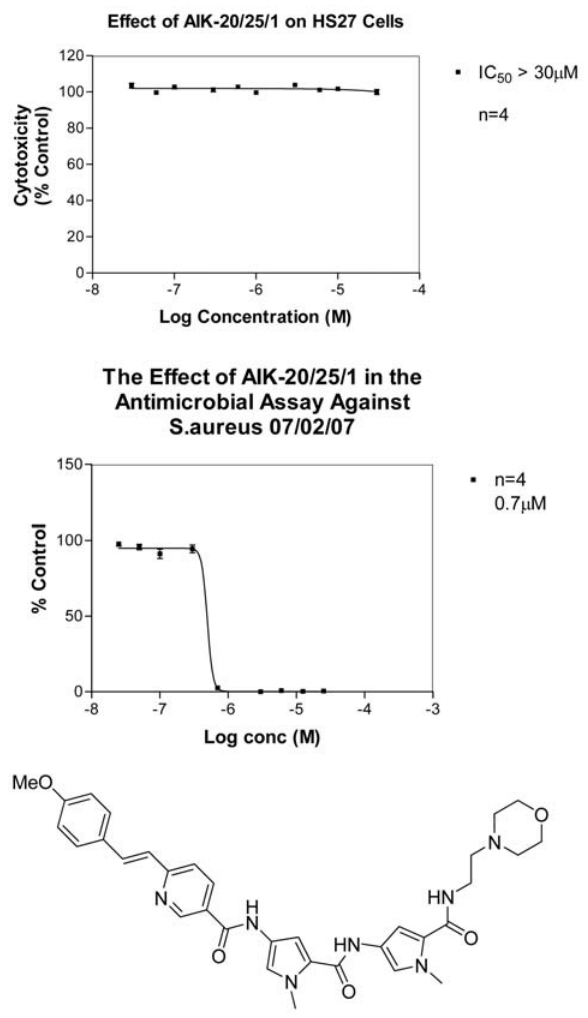
Fig. 7. Selectivity for Gram-positive bacteria shown by AIK- 20/25/1 (reproduced from Chem. Biol. Interface , reference 42). This is the original figure from our laboratories at